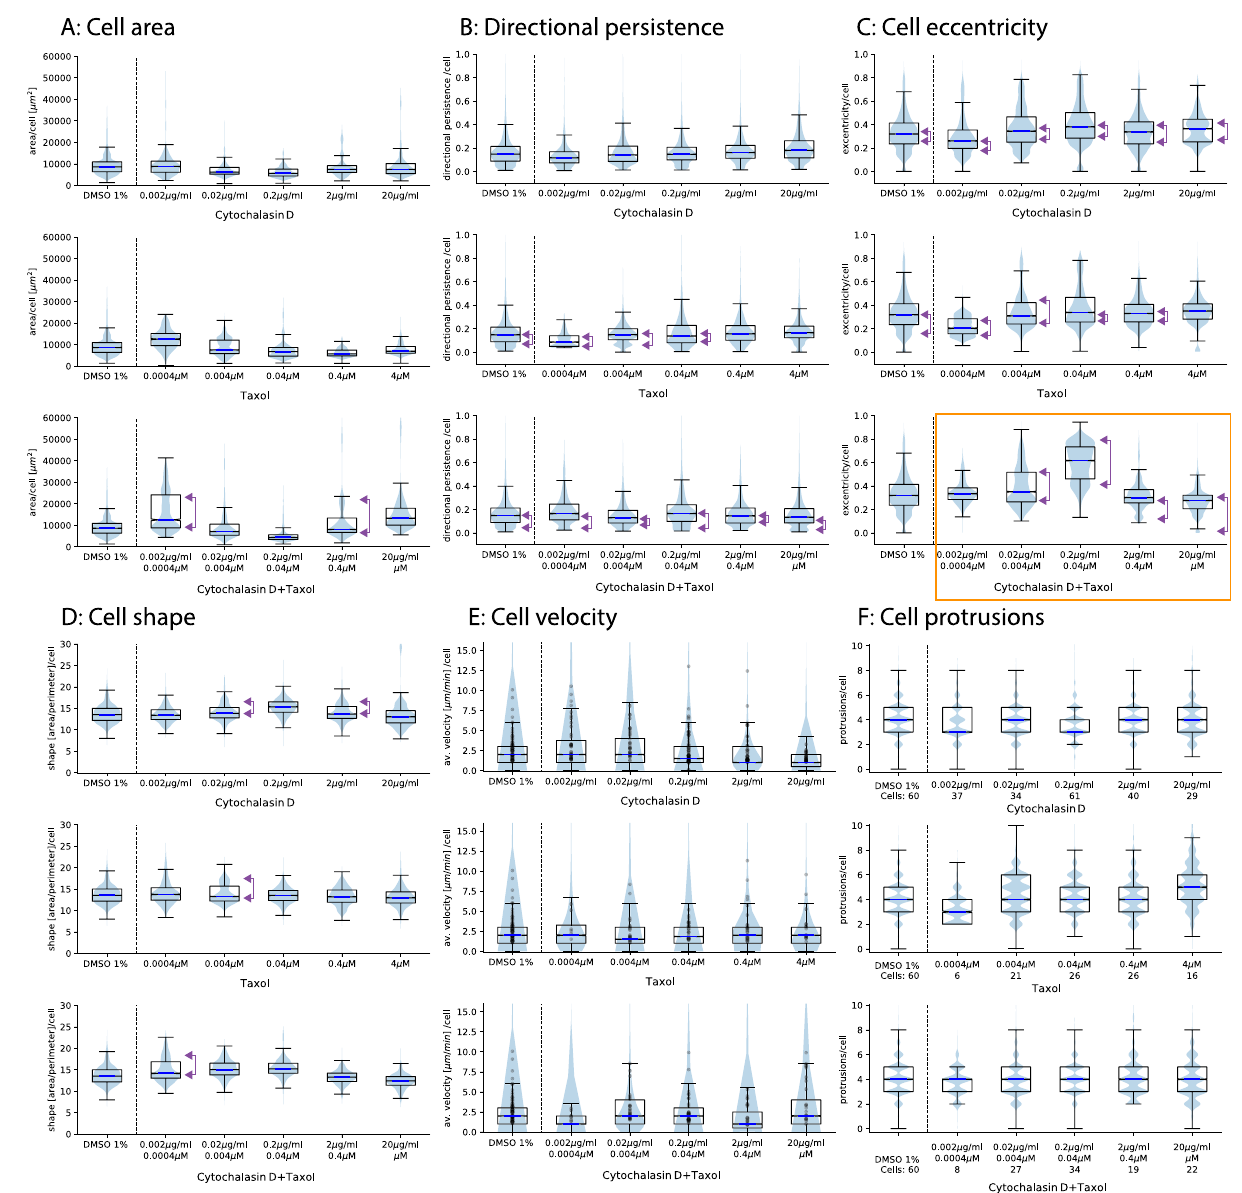
Figure 13. Cell property distribution per cell and per frame for six cell properties. For each cell property, we present the corresponding distribution for all cells within the FOV for the control samples, cytochalasin D (top) as well as taxol (middle) and cytochalasin D combined with taxol (bottom). The black dots within figure D represent the individual average velocity for each cell with in the corresponding FOV. The horizontal blue lines correspond to the mean velocity of each sample. The purple arrows indicate the abundance of